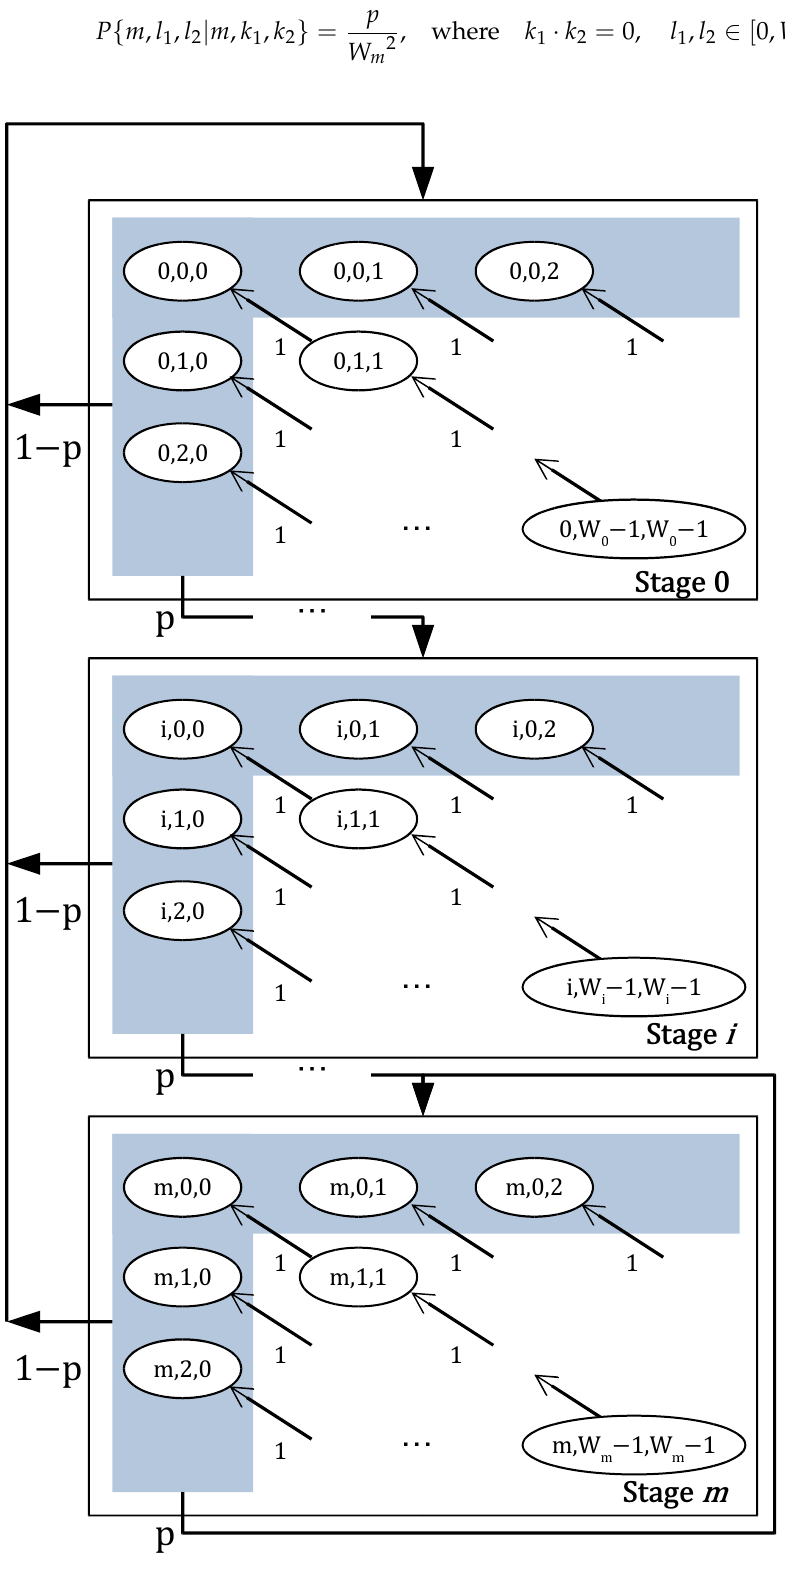
Figure 5. A 3D Markov Chain model of MLA-S when the two stations are affiliated with an